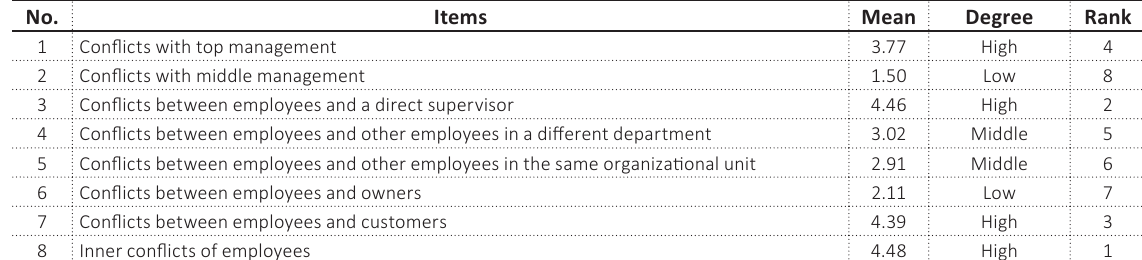
Table 4. Mean and the most common conflicts ranks